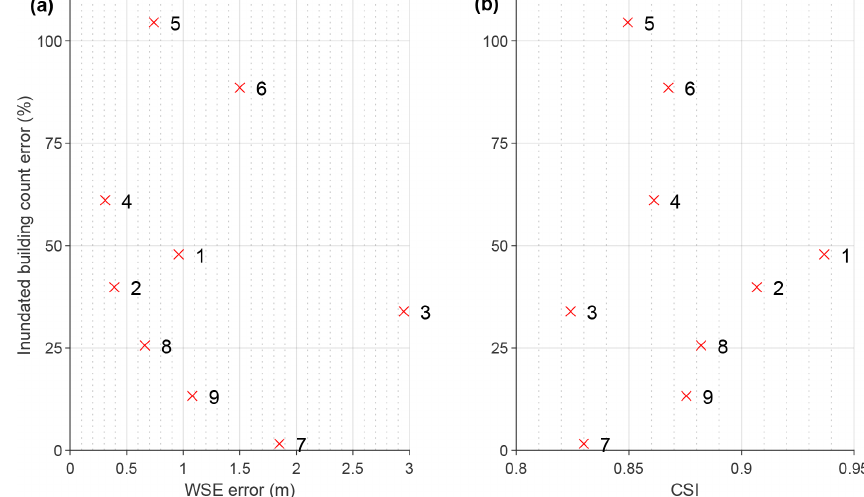
Figure 7. The relationship between inundated building count errors and (a) WSE error and (b) flood extent CSI for the nine events. Numbered crosses refer to the ID of the flood